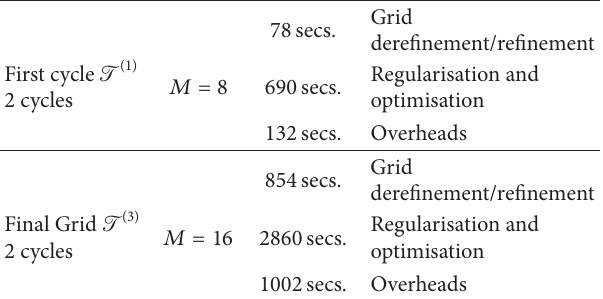
T 2: X29 aircra. Comparison of